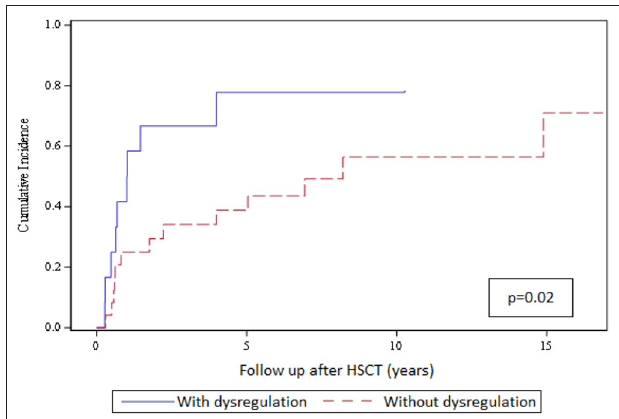
FIGURE 1 | Cumulative incidence of functional thyroid disorders in the 36 patients with structural thyroid changes and with or without signs of humoral immune dysregulation. The top curve represents the cumulative incidence of thyroid functional disorders in patients with structural thyroid changes and immune dysregulation ( n = 12; blue solid line); the bottom curve represents the cumulative incidence of thyroid functional disorders in patients with structural changes and no immune dysregulation ( n = 24; red dashed